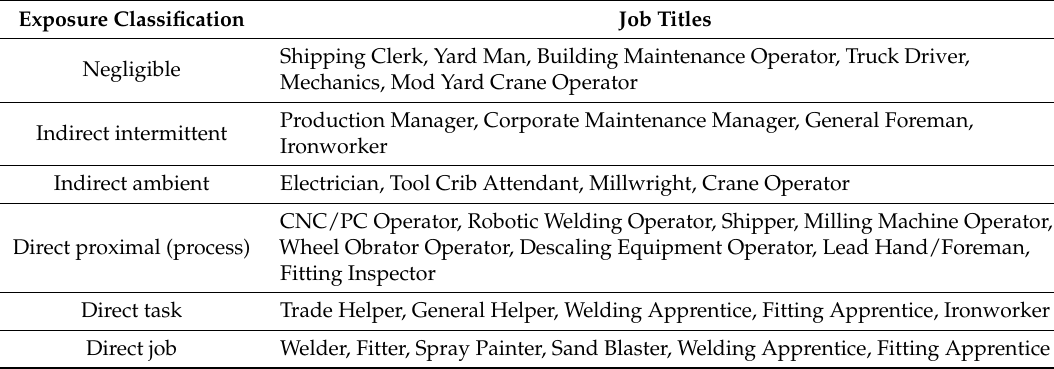
Table 1. Preliminary Similar Exposure Groups Determined Using Physical Demand Analysis. CNC/PC: computerized numerical control/personal